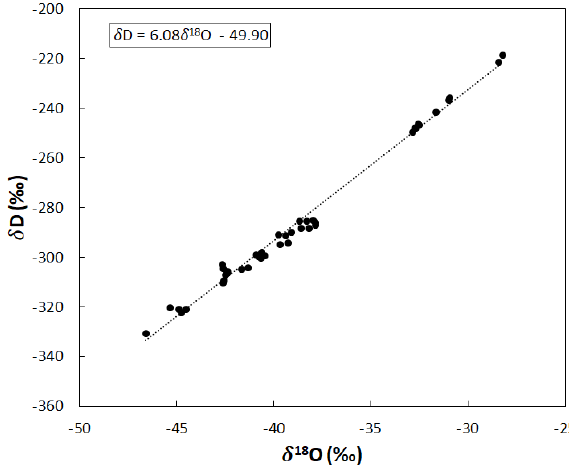
Figure A6. Relation plot between δ D and δ 18 O for all four flights as well as pod intercomparison tests taken at 2m.